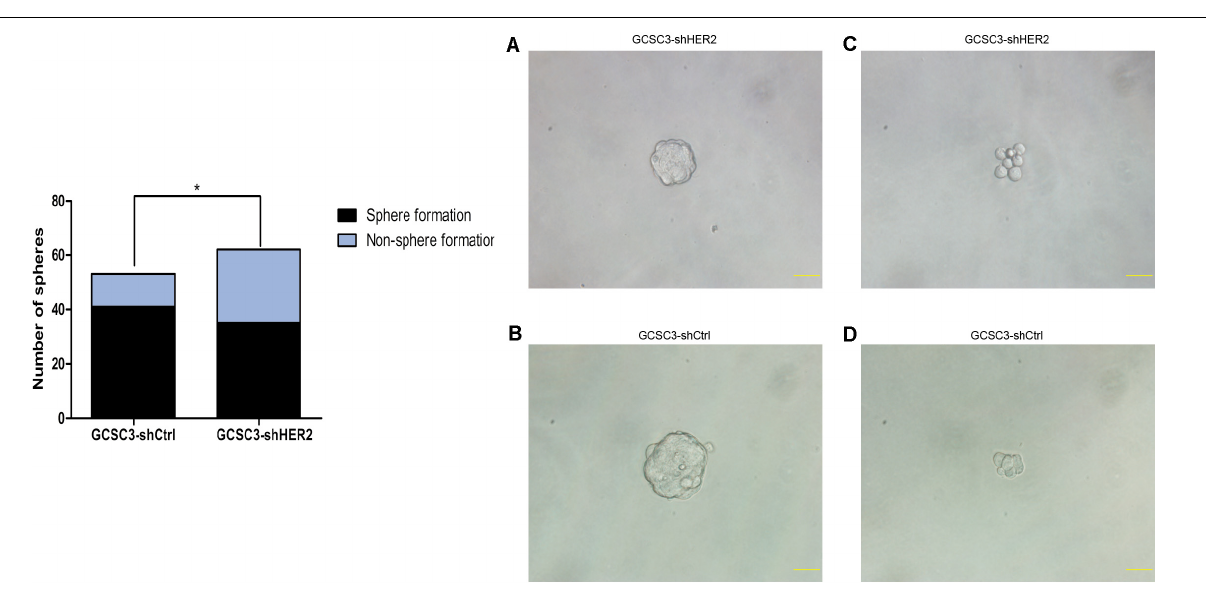
FIGURE 2 | The influence of HER2 on self-renewal ability in GCSCs was examined by sphere formation assay. Representative pictures were taken at × 400 magnification, and scale bars represent 40 µ m. Pictures (A,C) are GCSC sphere of GCSC3-shHER2 and GCSC3-shCtrl, respectively. Pictures (B,D) are non-sphere formation GCSC of GCSC3-shHER2 and GCSC3-shCtrl, respectively. The results showed that down-regulation of HER2 could decrease the self-renewal ability in GCSCs (77.36% vs. 56.45%, p = 0.029), * p <